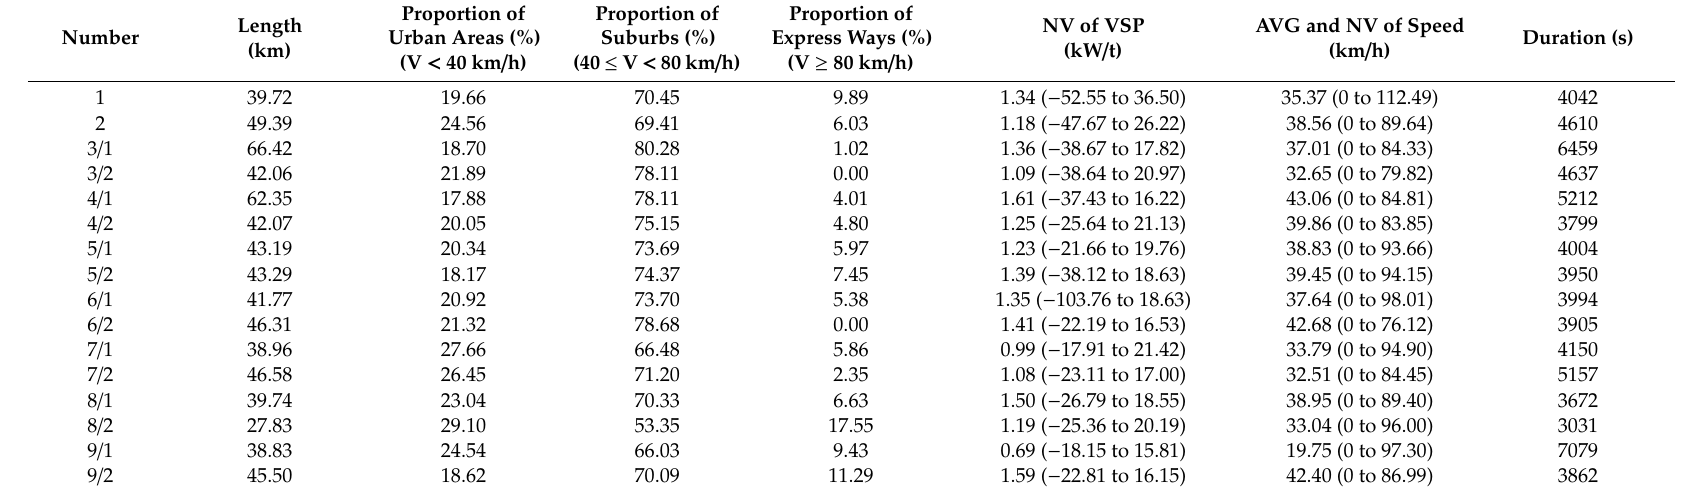
Table A3. Driving condition parameters of the test